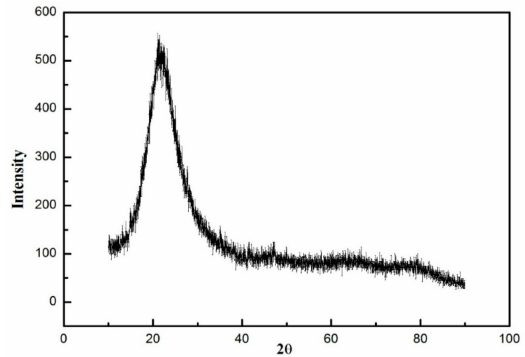
Figure 1. X-ray diffraction (XRD) pattern of dislodged sludge.